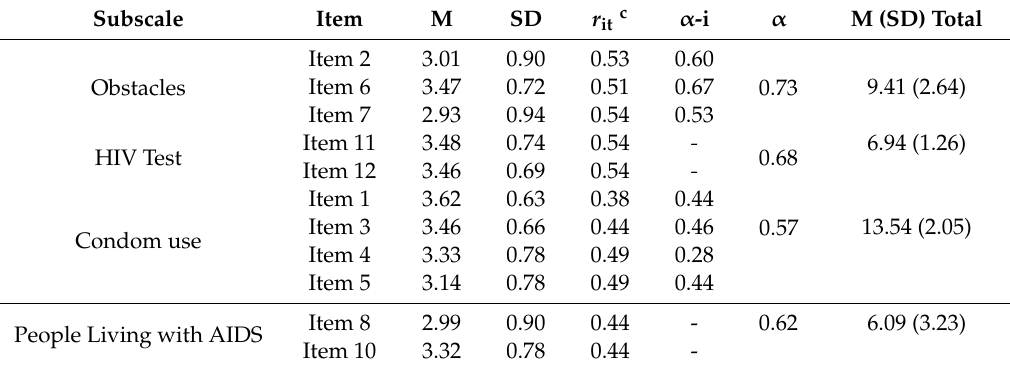
Table 4. Psychometric properties of items included in the HIV-AS